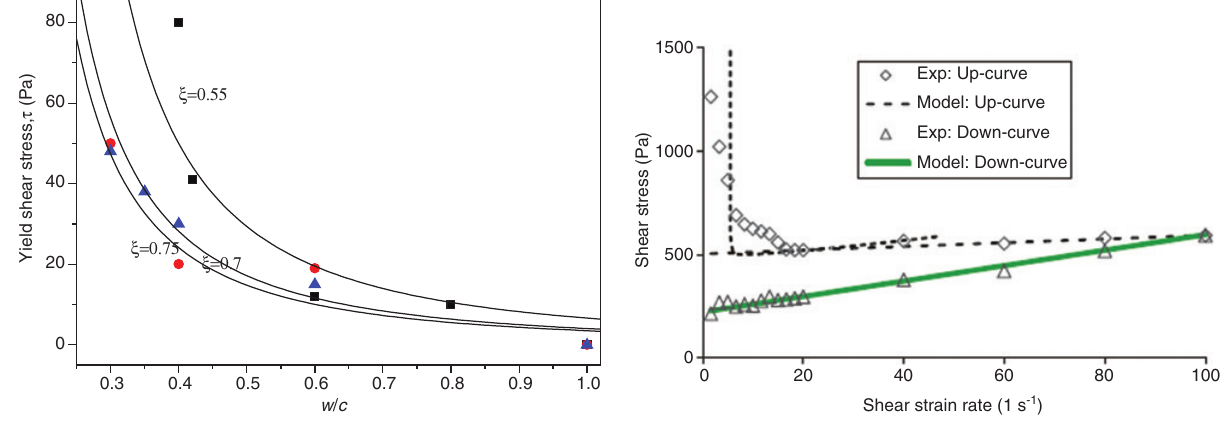
Figure 2: Plot of yield stress as a function of the water-to-cement ratio w/c .